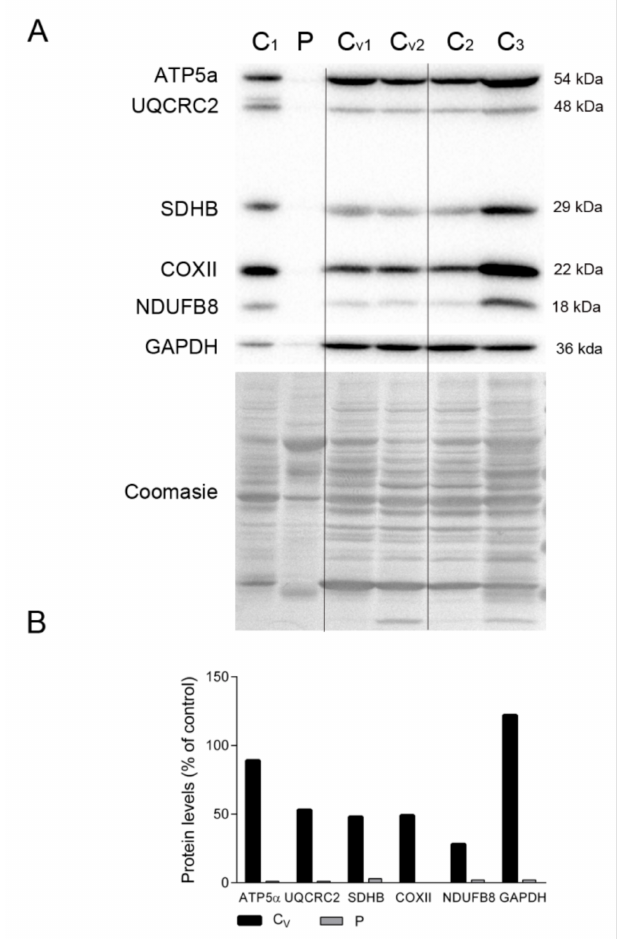
Figure 4. OXPHOS system subunits in patient and ventilated control diaphragms. ( A ) Representa- tive Western blotting of OXPHOS system subunits in diaphragm homogenates of non-ventilated controls (C, n = 3), ventilated controls (Cv, n = 2), and the patient (P). Shown below is a represen- tative Coomassie blue-stained gel. ( B ) Densitometry analysis: protein levels were normalized to total protein loading according to Coomassie blue staining. Data are expressed as percentage of non-ventilated control values. Abbreviations: ATP synthase subunit alpha; UQCRC2, ubiquinol- cytochrome C reductase core protein 2; SDHB, succinate dehydrogenase complex iron sulfur subunit B; COXII, cytochrome c oxidase subunit II; NDUFB8, NADH:ubiquinone oxidoreductase subunit B8; GAPDH, glyceraldehyde-3-phosphate